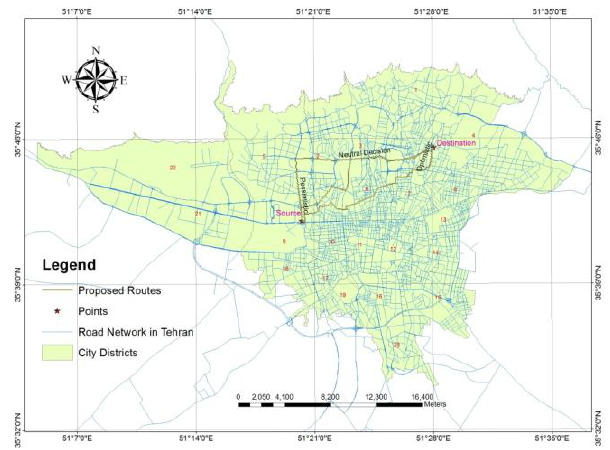
Figure 7. Routes based on optimistic and pessimistic views Figure 8 indicates 3 different routes for after earthquake based on different point of views. An optimistic decision maker pays no attention to the risk of road blockage and selects the shortest path, whereas a pessimistic one selects the route that is away from those non-standard buildings even if this route is longer (pessimistic users select the safest